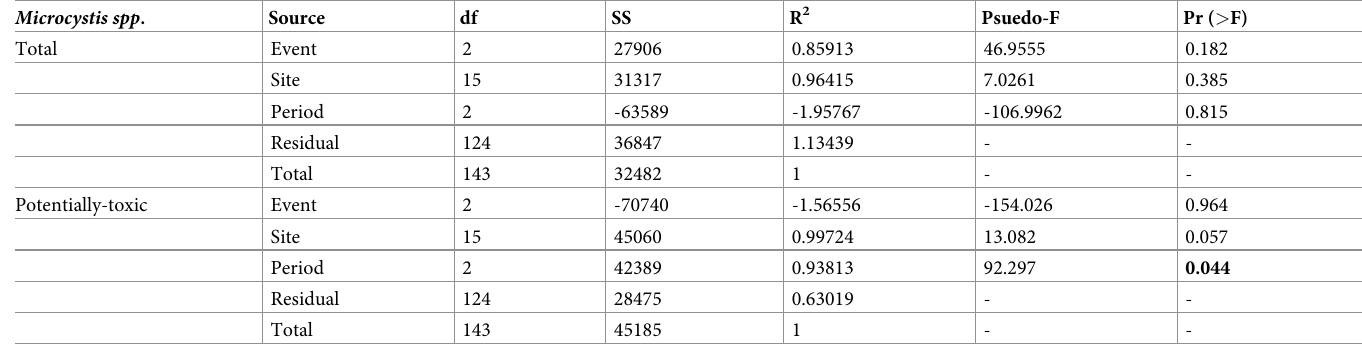
Table 5. PERMANOVA tests for both total and potentially-toxic Microcystis accumulation in cultures (cell equivalents mL -1 g -1 2 weeks -1 ) between sites (1.1–15.1), event (November 2014, April 2015, November 2015, and April 2016), and period (t 0 to t 2 , t 2 to t 4 , and t 4 to t 6 ). Tests were based on the non-Euclidean Bray-Curtis dis- similarity measure and were done using 999 permutations under the reduced model. Bold values indicate significant differences at p < 0.05. Microcystis spp